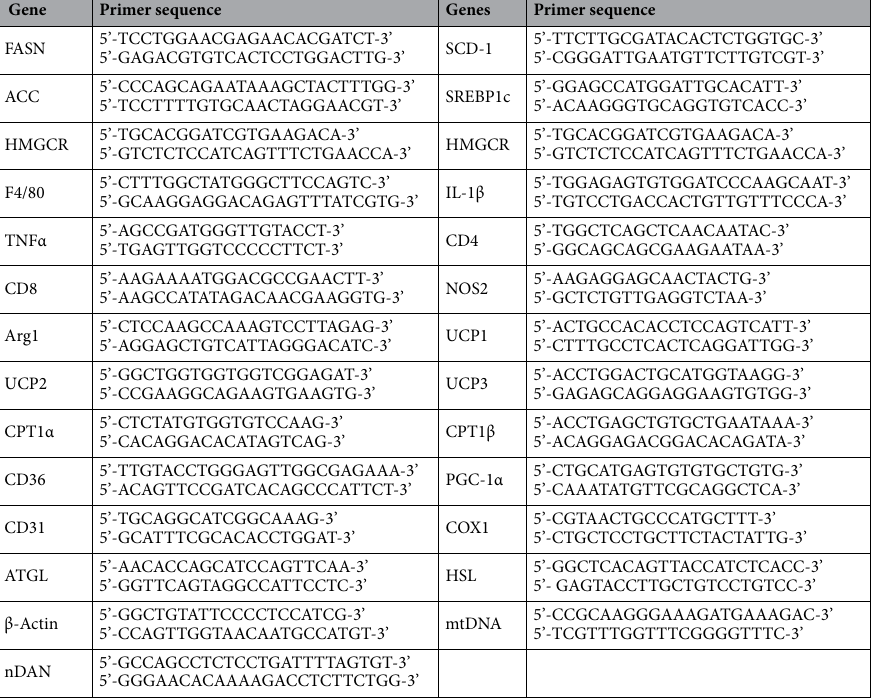
Table 1. Mouse primer Sequences for